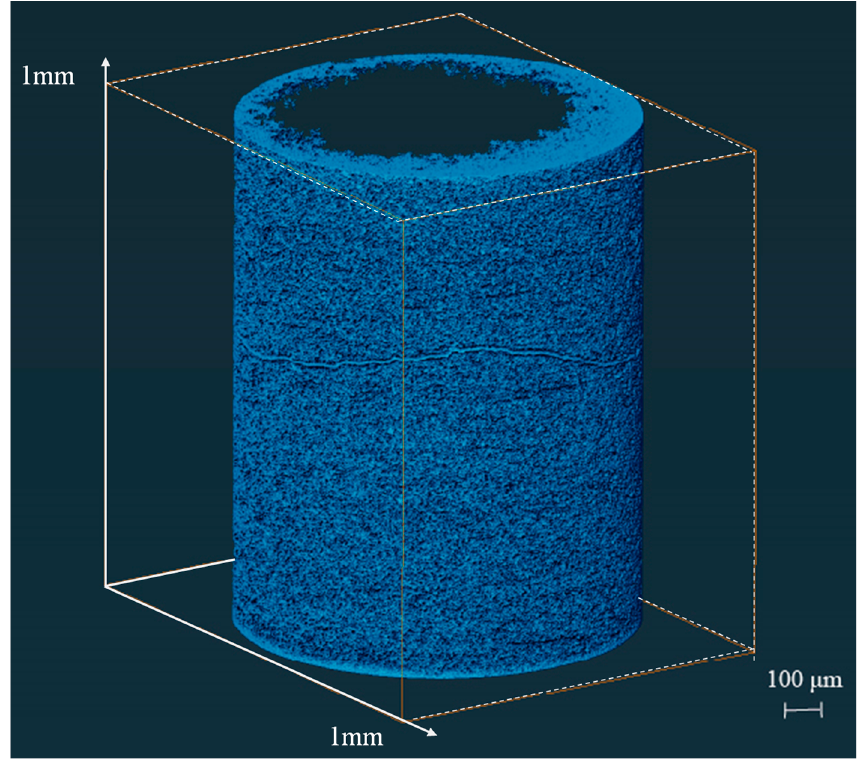
Figure 4. 3D reconstruction of S41 sample after threshold segmentation.